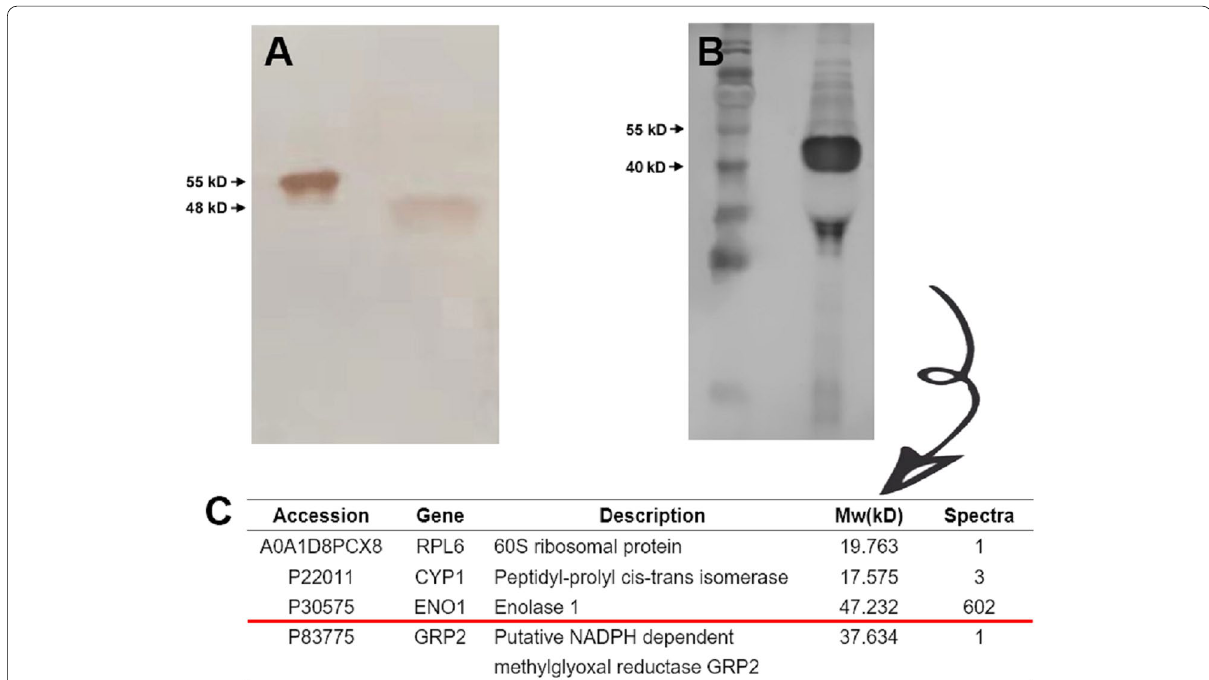
Fig. 1 Validation of the specificity of 9H8 mAb. A Western blot analysis showed the 9H8 mAb specifically reacted with the 55 kD recombinant CaEno and recognized a 48-kD protein in the Candida albicans total lysates. B SDS-PAGE (sliver stained) analysis of the 9H8 immunocapture elute. C